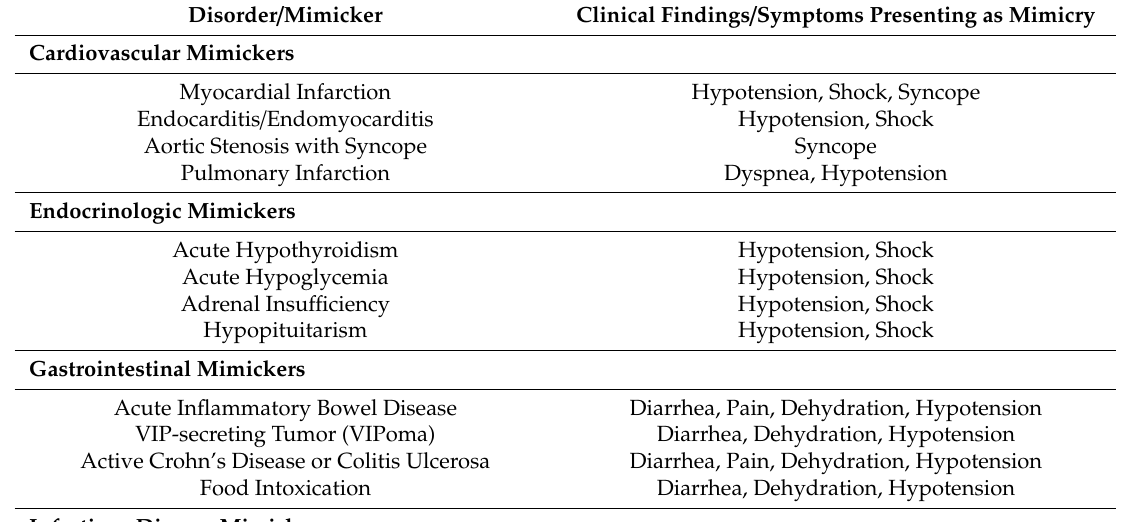
Table 4. MCAS Mimickers: Di ff erential Diagnoses to MCAS